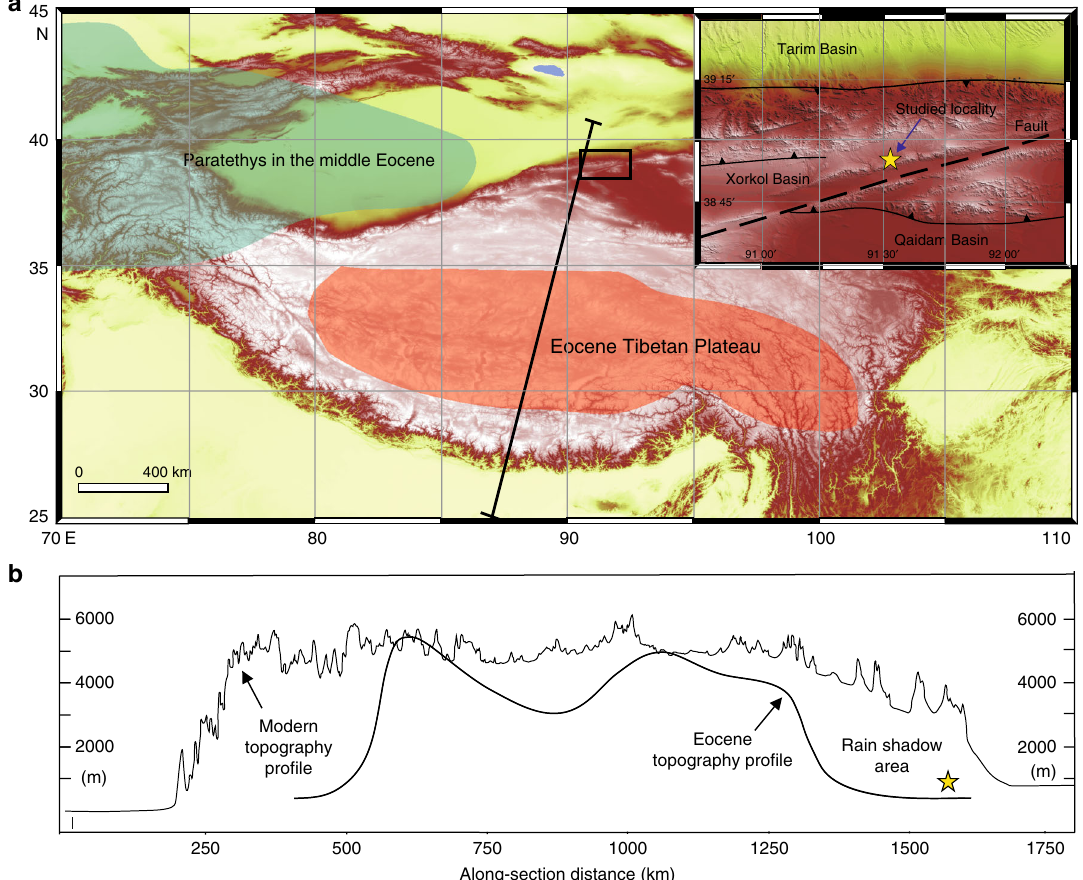
Fig. 1 Topographic map of the study location and surrounding region. a Present day topography of the Tibetan Plateau and location of the study site. The sub- fi gure is focused on the Altun Shan and surrounding area. Also shown in a are the estimated extent of the Paratethys Sea 60 and the estimated extent of the Tibetan Plateau in the Eocene 13 . b Topographic pro fi les across the Tibetan Plateau for the present day and early Eocene periods. The star indicates the location of the studied stratigraphic sequence. The early Eocene reconstruction is from ref. 13 . The digital elevation data are from